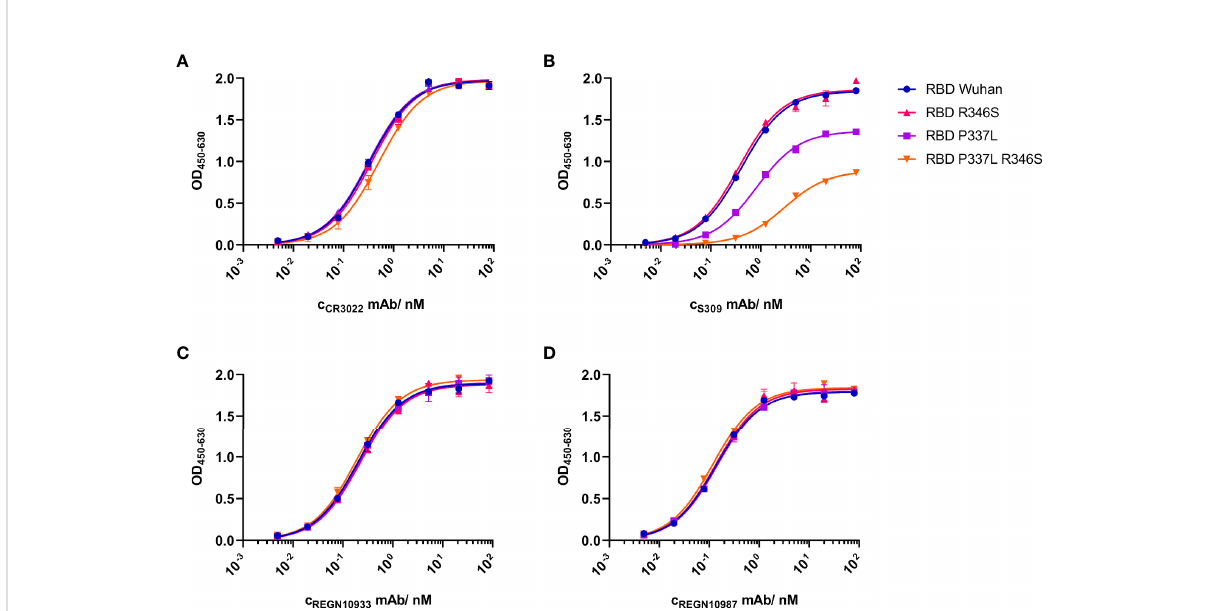
FIGURE 3 Impact of de novo amino acid exchanges R346S and P337L on the binding of monoclonal antibodies to the SARS-CoV-2 receptor-binding domain (RBD). Recombinant soluble variants of RBDs with the Wuhan-Hu-1 sequence (blue circles), R346S (red triangle), P337L (green square), or both amino acid exchanges (orange triangle) were analyzed in an ELISA. Binding af fi nities of monoclonal antibodies (mAB) were measured as optical density (OD) across eight serial dilutions (80 nM to 49 pM) of (A) non-neutralizing CR3022, (B) neutralizing S309, and neutralizing (C) REGN10933 and (D) REGN10987 antibodies. Data are shown as mean of duplicates out of one experiment. Corresponding Grated-Coupled Interferometry data are shown in Supplementary Figure